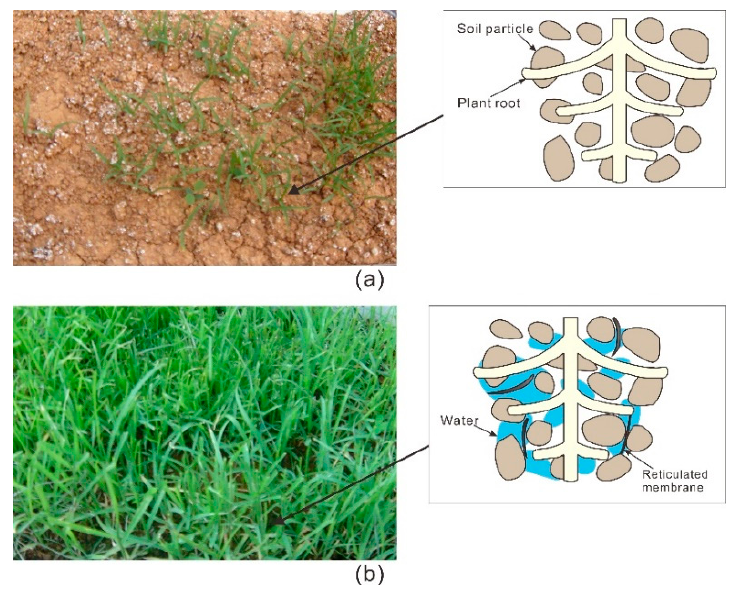
Figure 8. The picture and schematic diagram of seed growth with different polymer concentrations after 30 days: ( a ) 0%; ( b ) 30%.